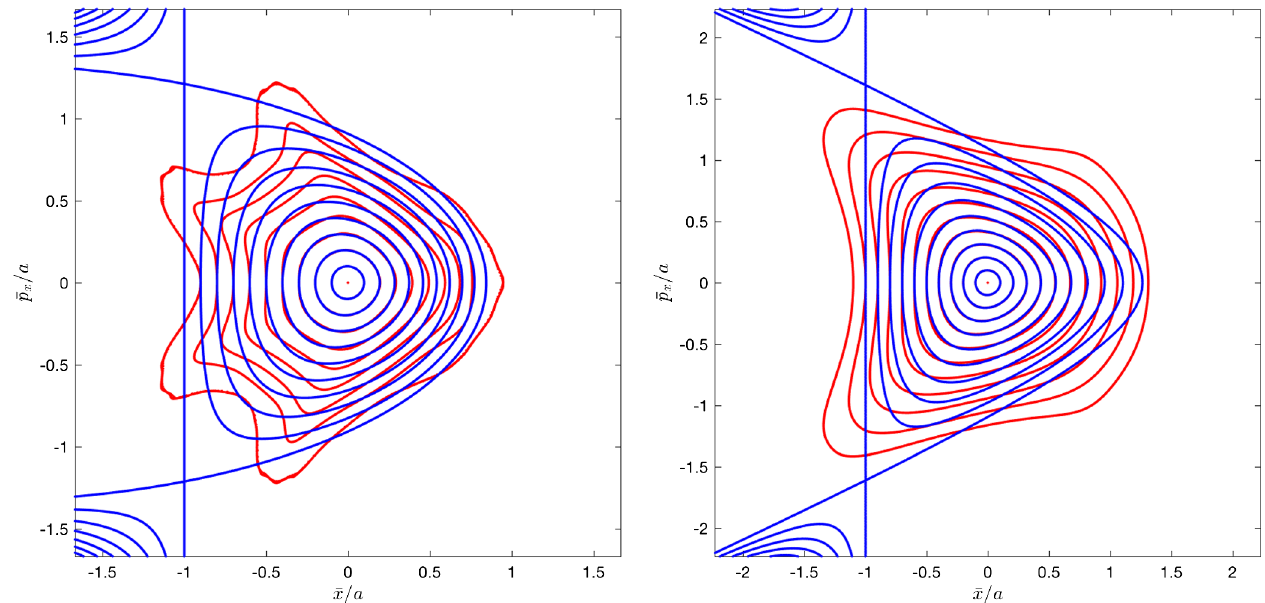
FIG. 7. Comparison of the contours (blue color) of the effective Hamiltonian and the stable orbits (red color) by tracking using the symplectic maps with ν ¼ 0 . 194 (left) and ν ¼ 0 . 28